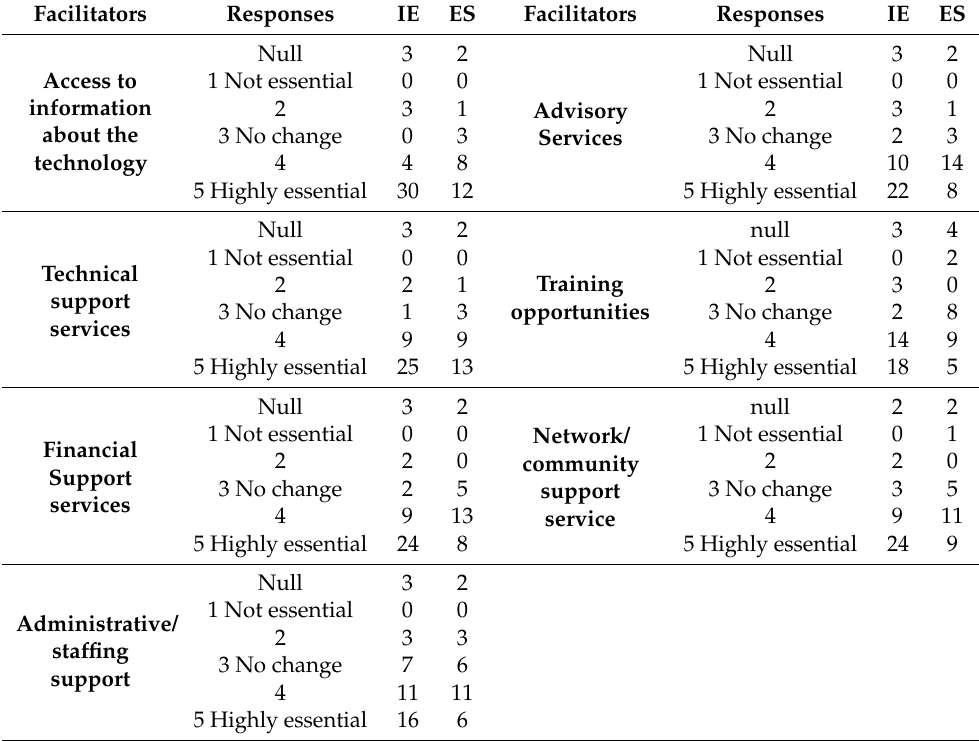
Table 5. Facilitating the adoption of MHP in Ireland (IE) and Spain (ES).